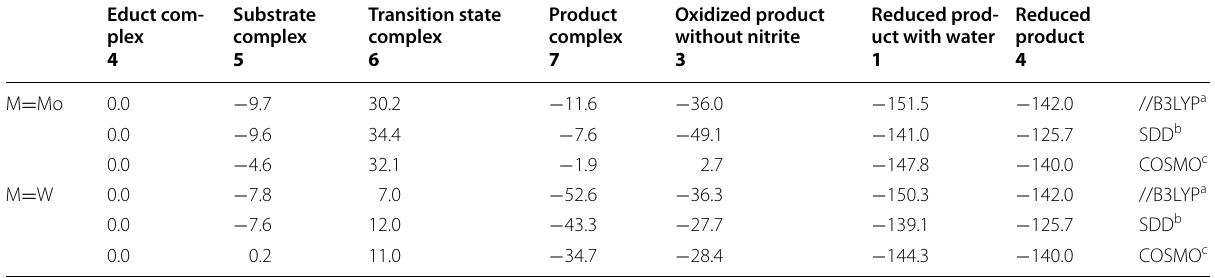
Table 3 Computed energies (kcal/mol) relative to the educt–substrate complex for the nitrate